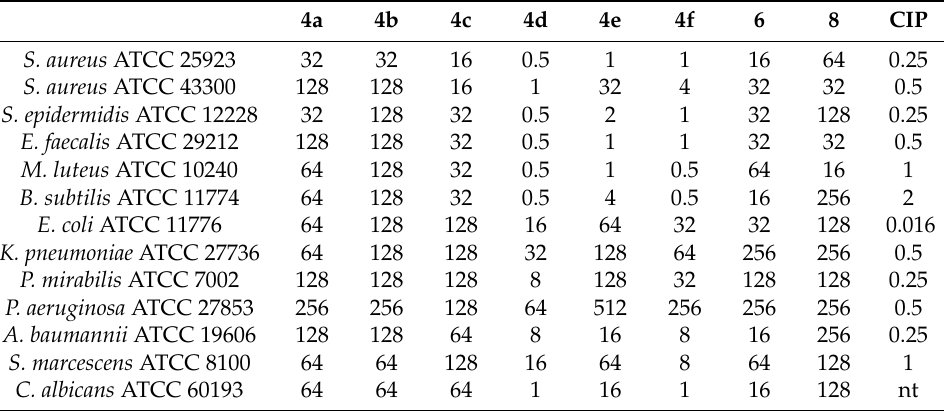
Table 1. Evaluation of the minimum inhibitory concentration (MIC) ( µ g/mL) of quinolinium salt sulfur derivatives against tested bacterial